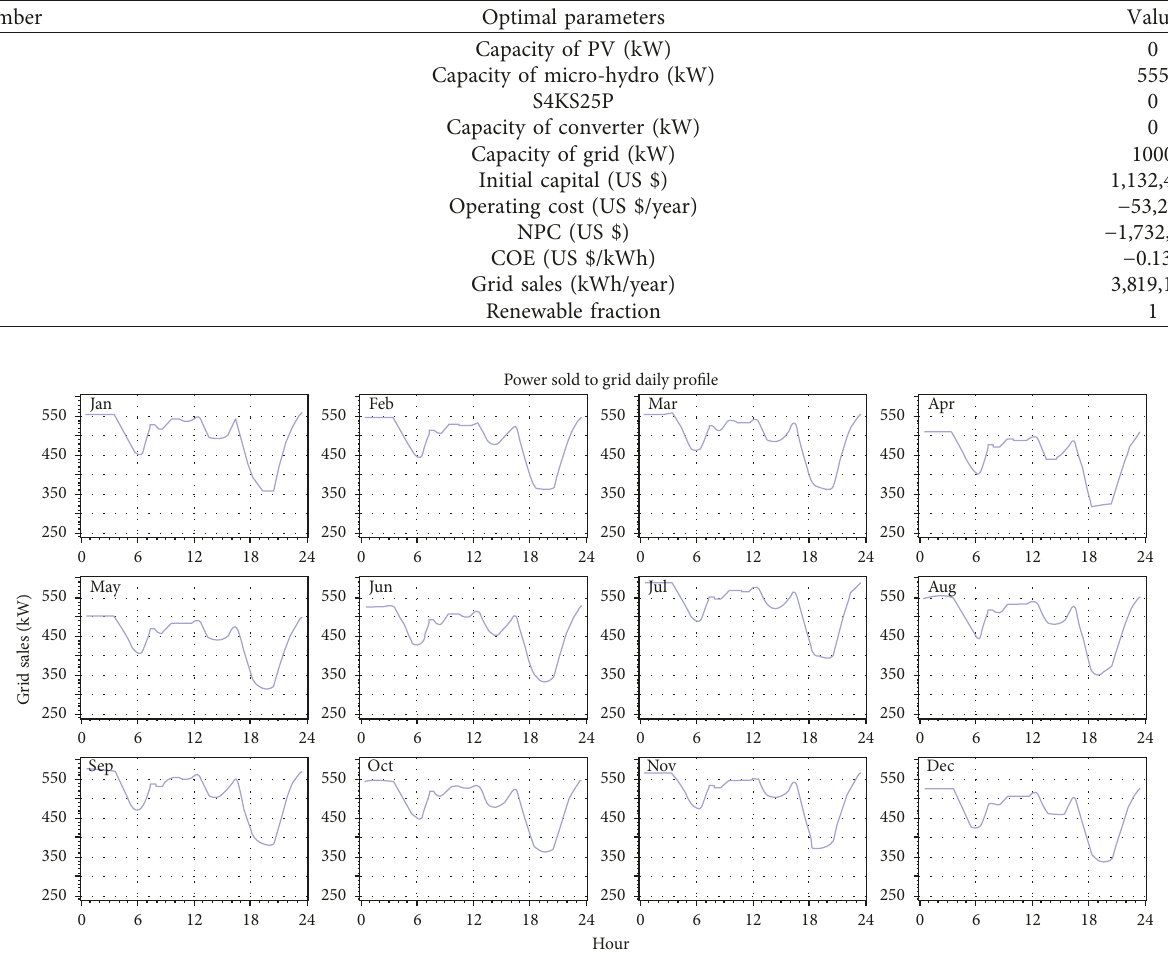
Figure 23: Average monthly electric power production by hybrid power plant systems that can be sold to state-owned electricity